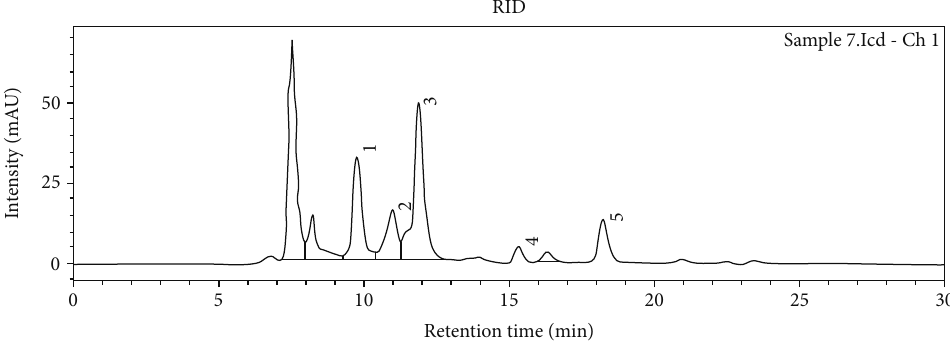
Figure 4: Representative HPLC chromatogram of cocoa bean sample from various regions in